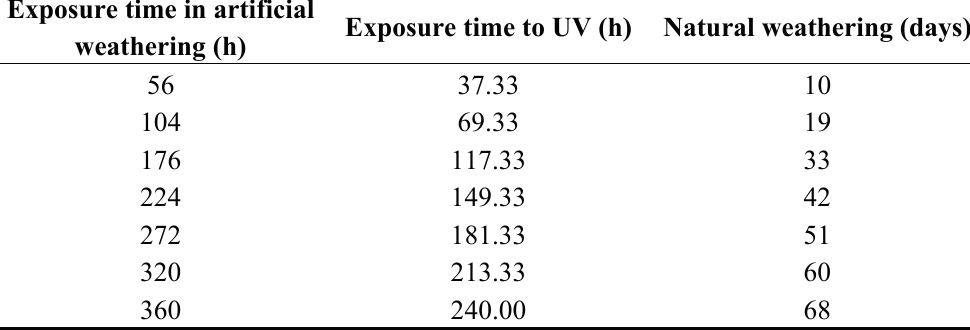
Table 4. Correlation of natural and artificial